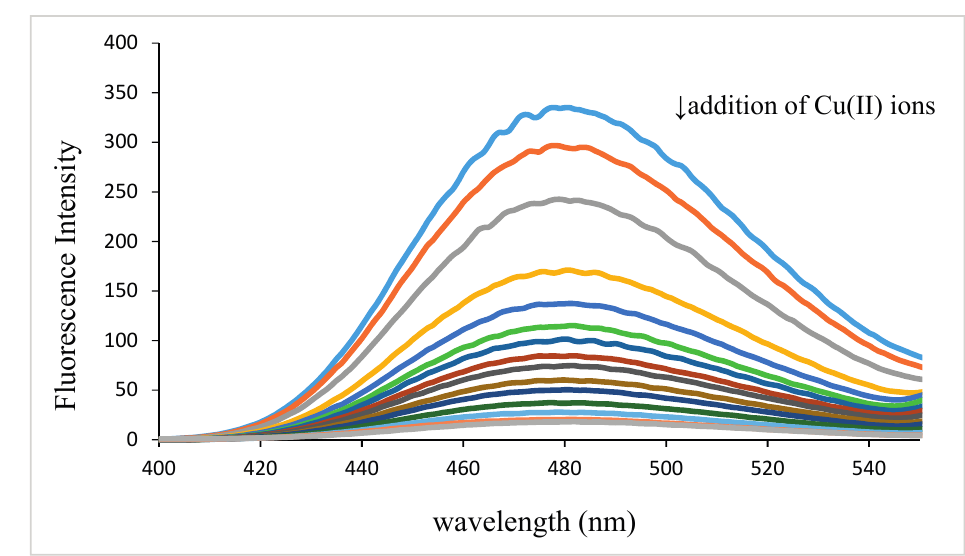
Figure 6. Fluorescence emission spectrum of levofloxacin (2 × 10 − 5 mol/L, λ in aqueous solution at pH 7.4 in the presence of Cu(II) ions (concentration range of Cu ion: (0–1) × 10 − 3